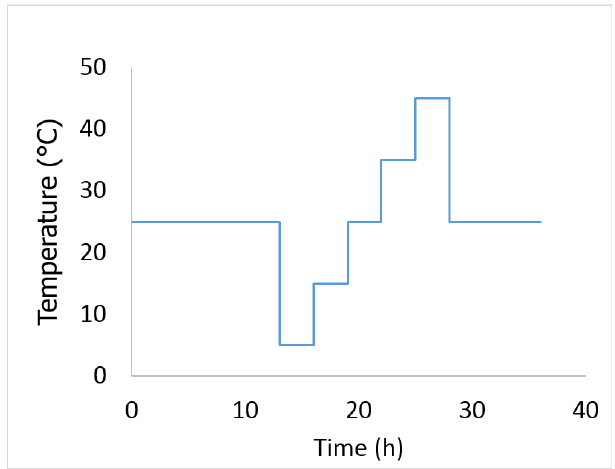
Figure 3. The temperature profile used for determining dU ocv / dT term.